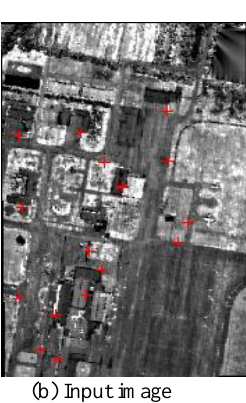
Figure 5: Image registration from test set 2